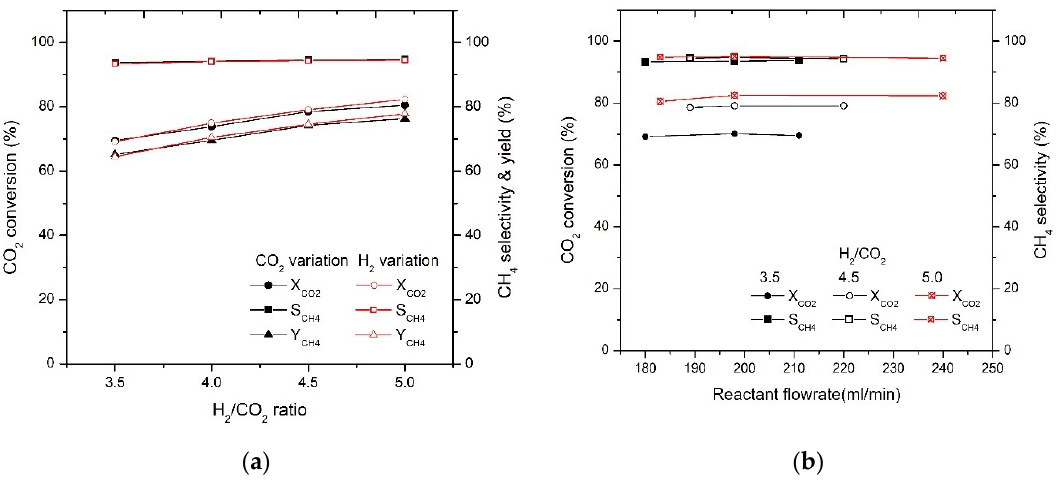
Figure 2. Effect of H 2 /CO 2 mole ratio along with ( a ) CO 2 or H 2 variation; ( b ) reactant amount variation. Figure 2. E ff ect of H 2 / CO 2 mole ratio along with ( a ) CO 2 or H 2 variation; ( b ) reactant amount